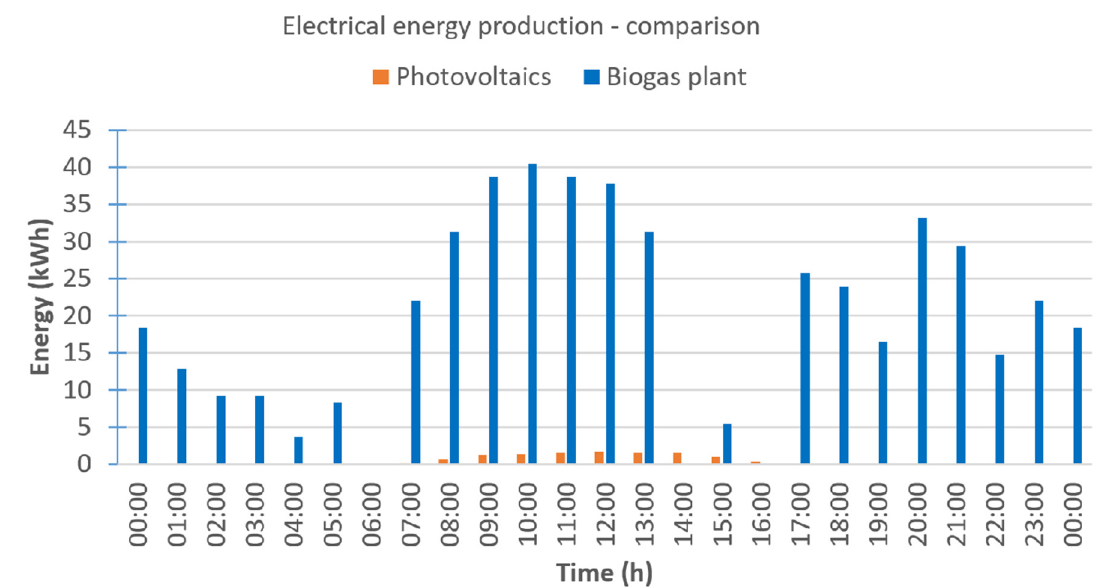
Figure 8. Electrical energy production profile comparison during a 24 h cycle. Own study based on source [55].